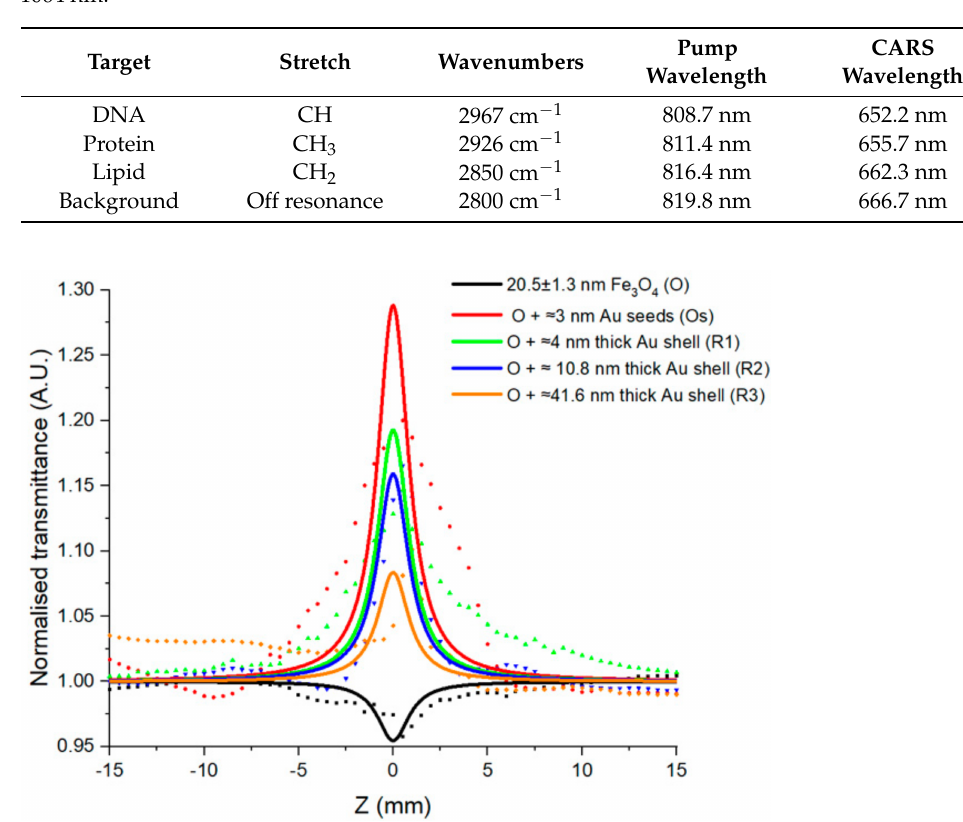
Figure 3. Open aperture transmission z-scan obtained for Fe 3 O 4 nanoparticles and Fe 3 O 4 nanopar- ticles with various thicknesses of gold. The solid line is the fit of the normalized transmittance expression of the experimental data